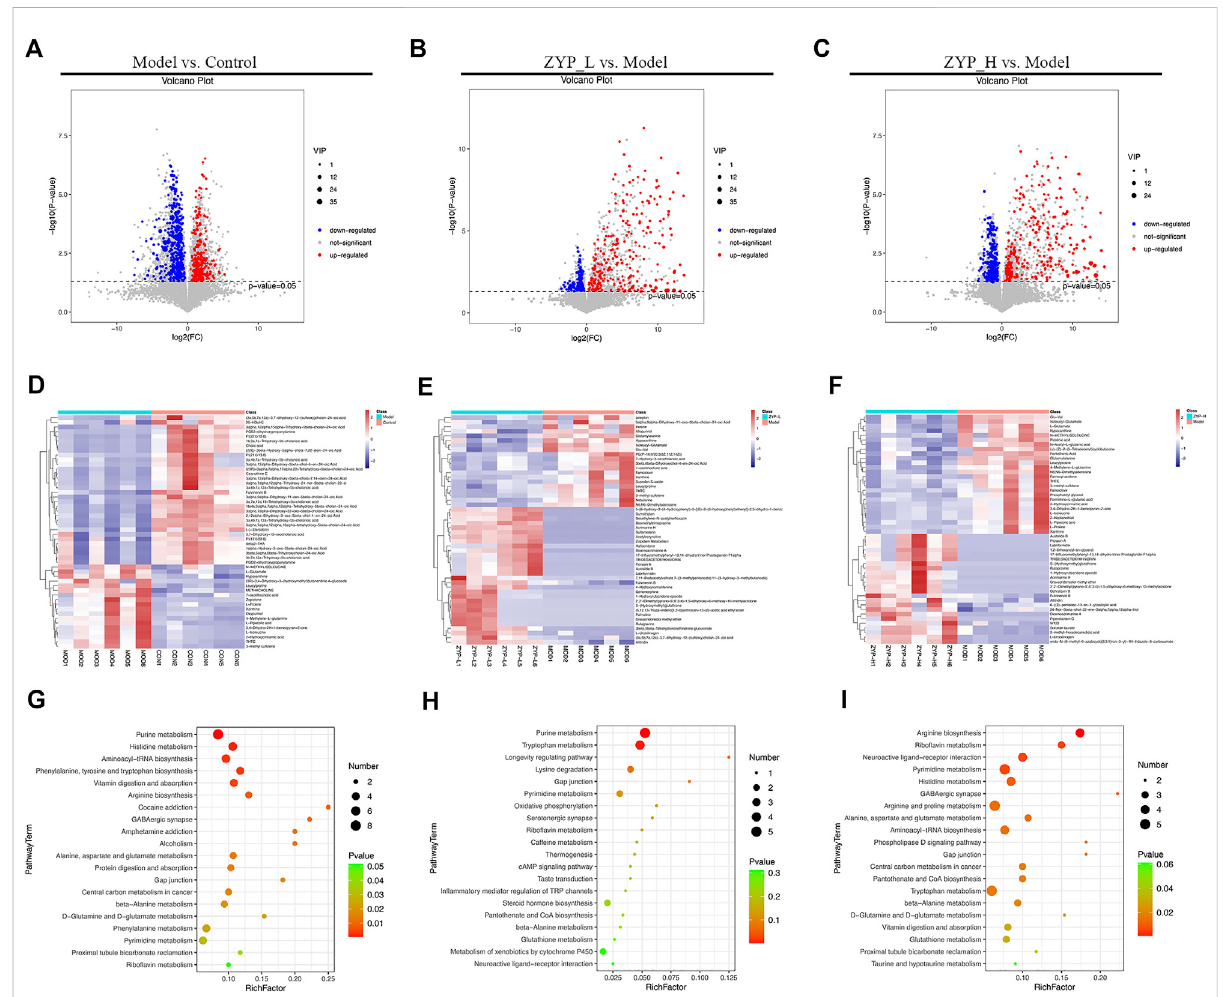
FIGURE 3 Volcano plot, heat map, and bubble diagrams of the control, model, and ZYP treatment groups. (A – C) Volcano plot of rat fecal metabolites. Each point represents a metabolite, and the point size represents the VIP value; (D – F) Heat map of rat fecal metabolites. Red represents a higher relative abundance, while blue illustrates a lower relative abundance; (G – I) Bubble diagrams of rat fecal metabolites. The color of each circle indicates the p -value, and the size of each circle re fl ects the varying metabolite number of each